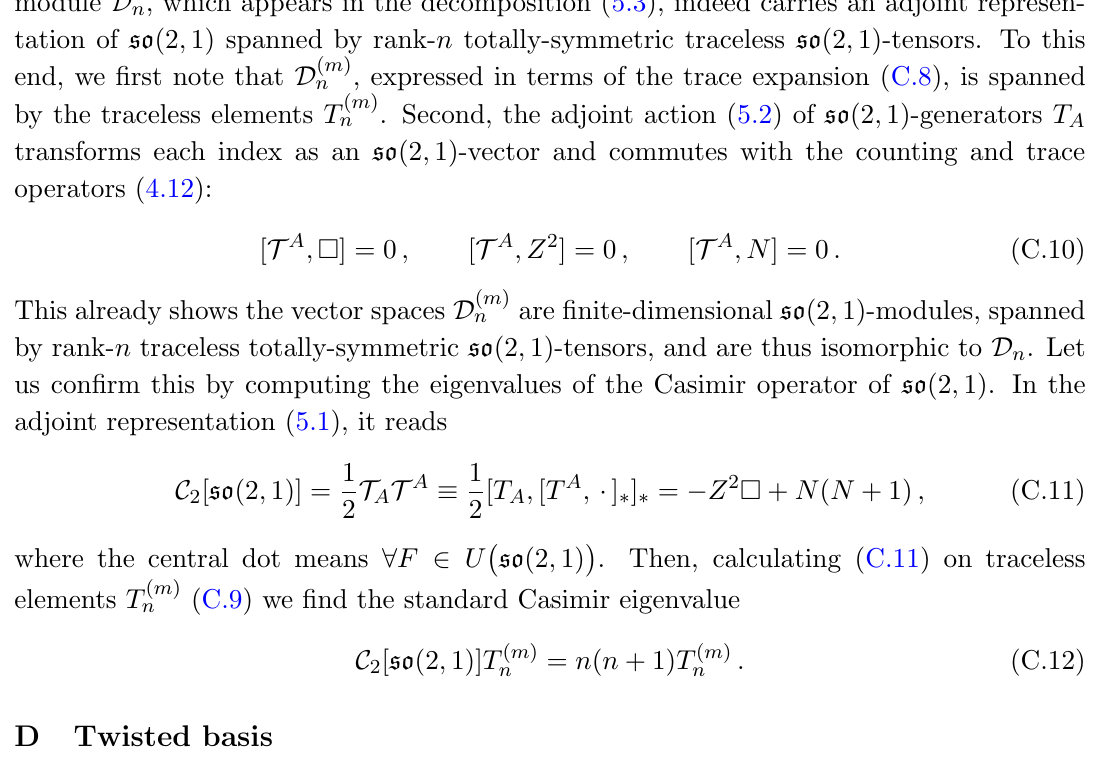
so (2 ; 1) . The (cid:0) (cid:1)